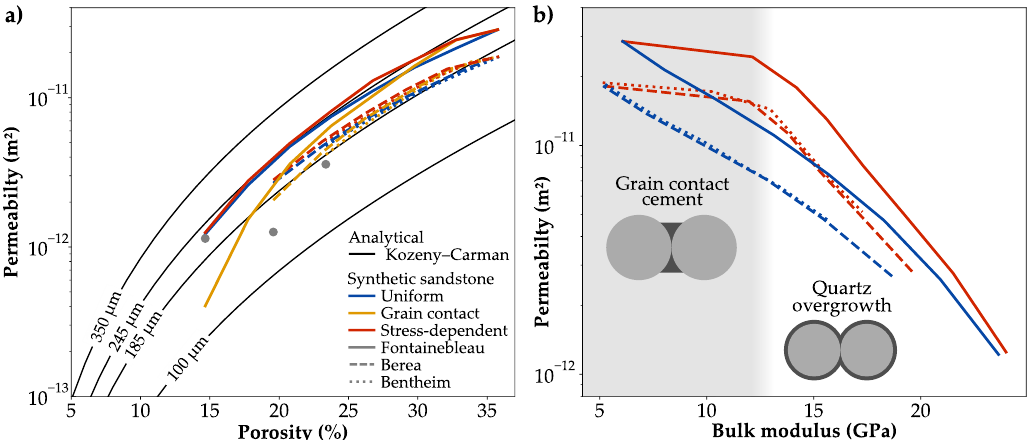
Figure 10. ( a ) Permeability evolution of the three synthetic samples cemented by the uniform (blue), contact-preferential (or- ange) and stress-dependent scheme (red) compared to the Kozeny–Carman approach (black) for different grain diameters. ( b ) Cross-trends for permeability and bulk modulus emphasise the requirement for the stress-dependent scheme combining initial contact cementation and subsequent quartz